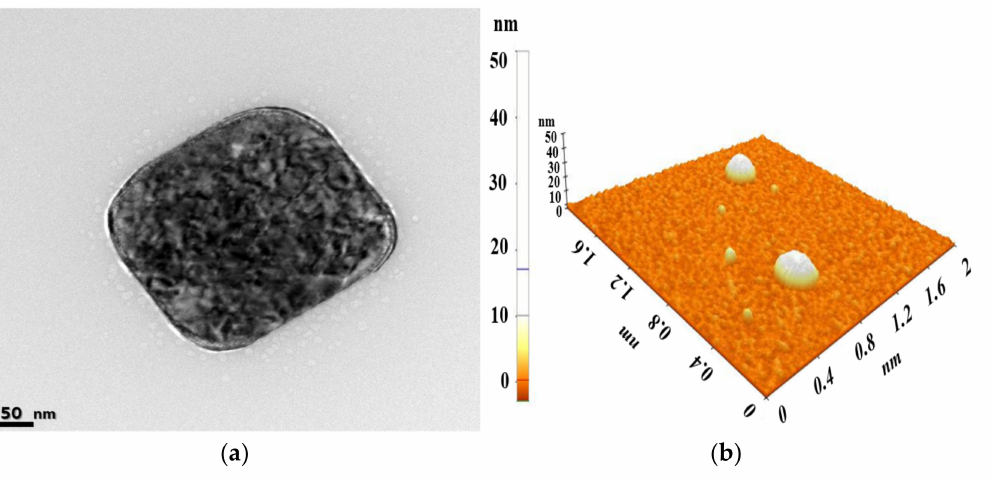
Figure 3. Morphological characterization of PL-SALCs (F6 formulation) using ( a ) FE-TEM (scale bar represents 50 nm) and ( b ) AFM. Abbreviations: SALCs, self-assembled liquid crystalline nanoparti- cles; FE-TEM, field emission transmission electron microscopy; AFM, atomic force